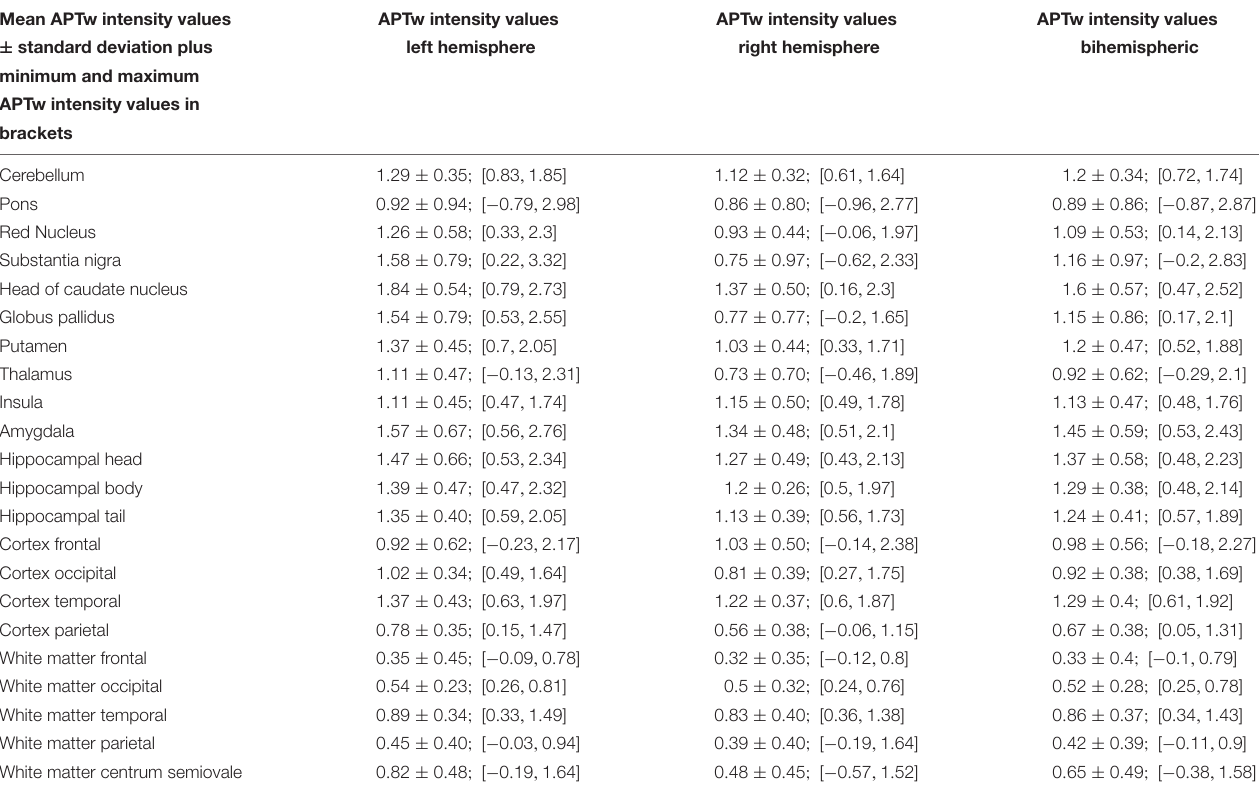
TABLE 2 | Normal APTw intensity